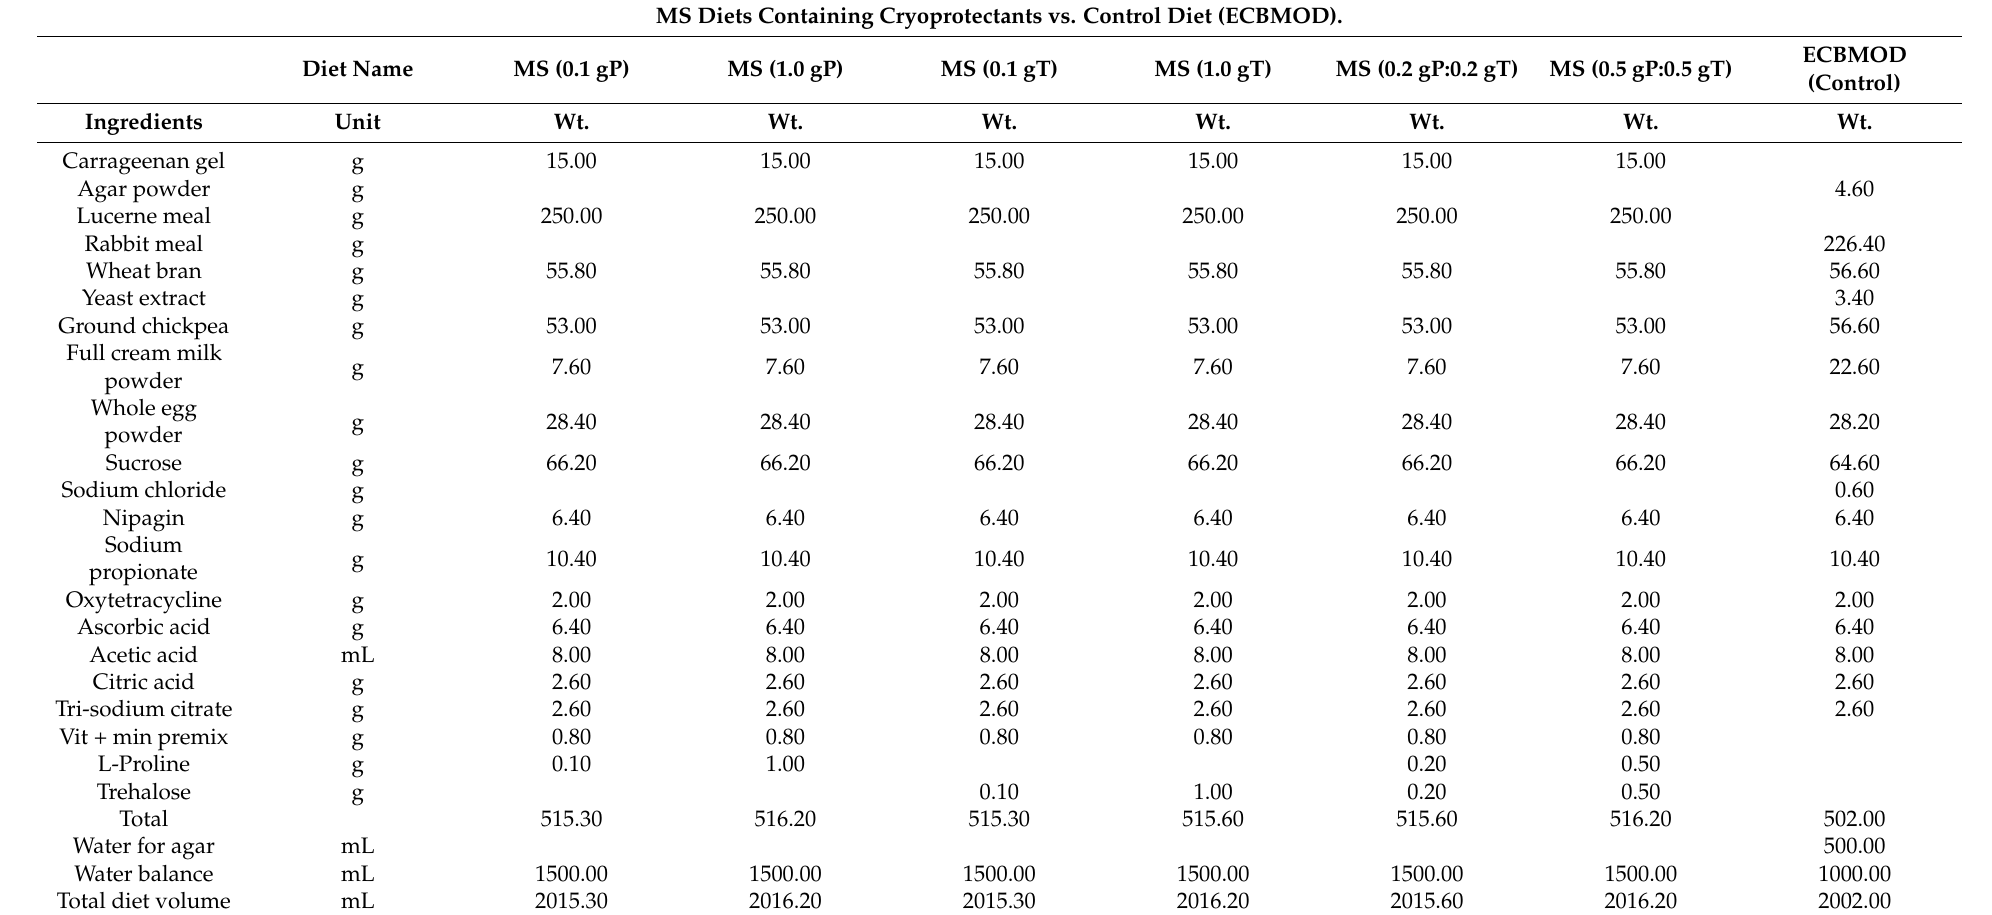
Table 2. Eldana saccharina MS diet with incorporation of different cryoprotectant components and ECBMOD control diet